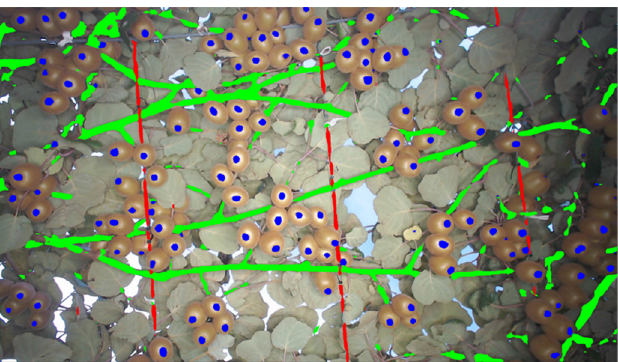
Figure 7. Semantic segmentation for kiwifruit’s calyx (Photo: Reprinted with permission from Ref. [43]. 2019, Williams H.A.).